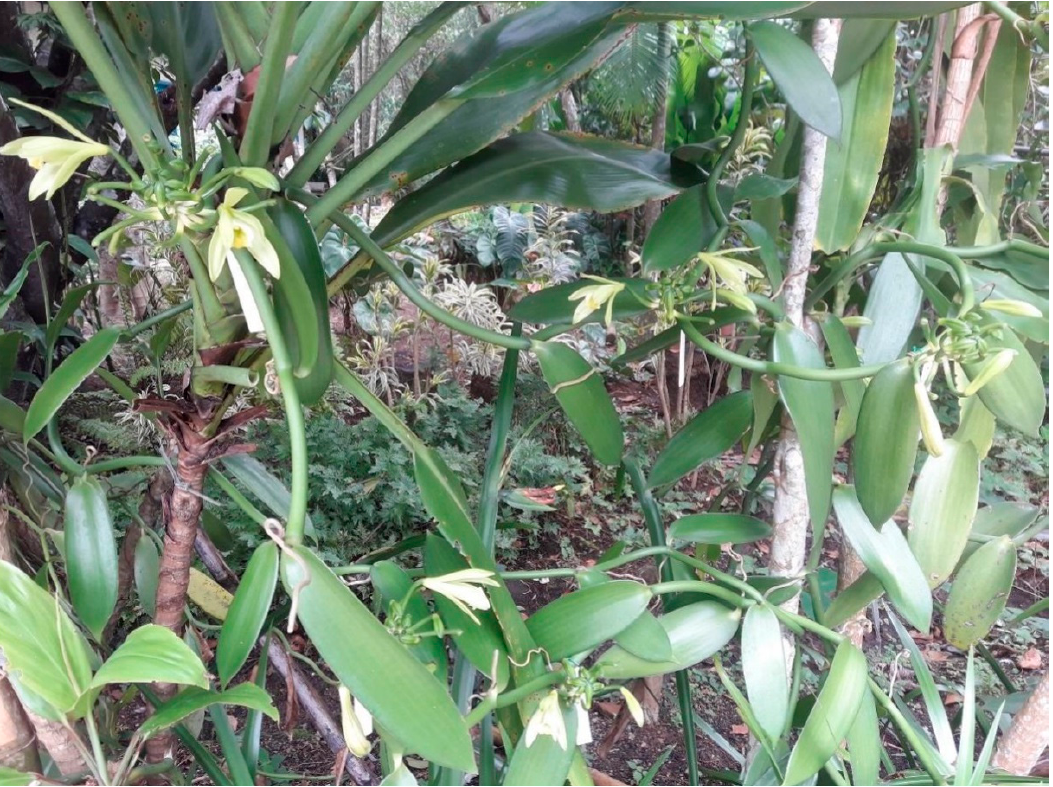
Figure 1. Habit of Vanilla planifolia in the Orchid Garden of the Botanical Garden of Rio de Janeiro, city of Rio de Janeiro (RJ, Brazil). Photo by: Aires Vanessa C. dos Santos.